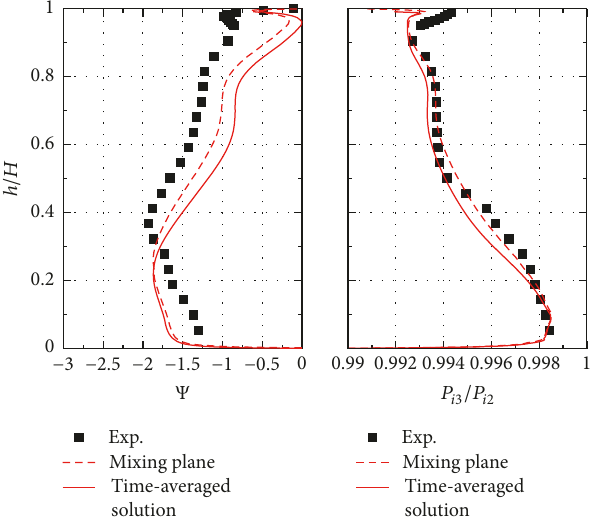
Figure 5: Experimental and numerical rotor work and